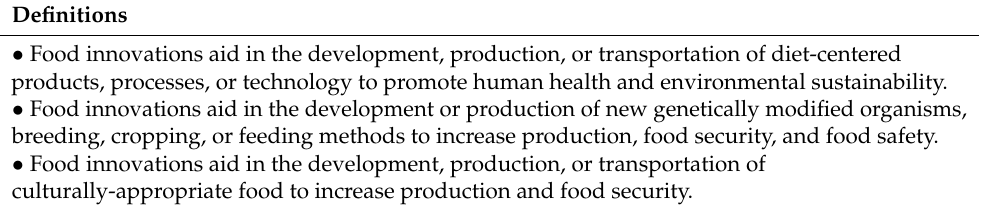
Table 1. Food innovation definitions and specific food innovation themes.